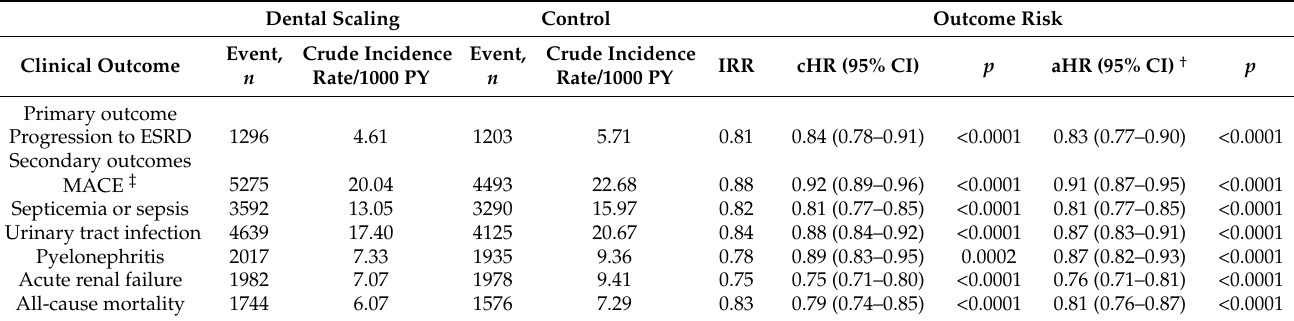
Figure 2. Cumulative incidences of ESRD between people with and without dental scaling ( A ), and with a varying frequency of dental scaling ( B ), with the number of subjects at risk. Table 2. Risk of progression to ESRD and other complications for CKD cases receiving dental scaling treatment and matched